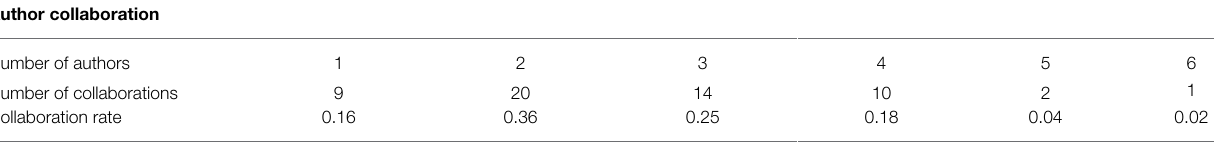
TABLE 5 | Rate of author collaboration in neuroentrepreneurship